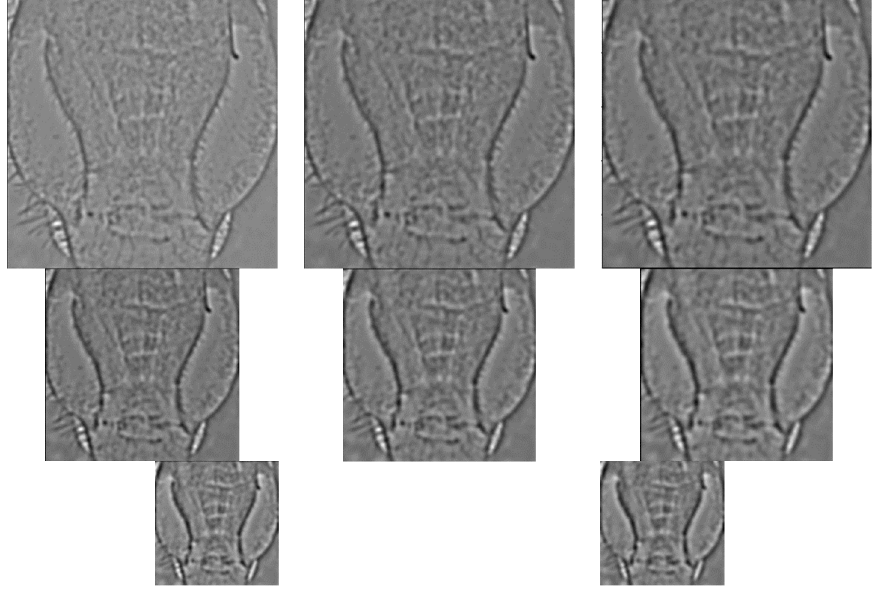
Figure 11. Image pyramid after applying difference of Gaussian or DoG.